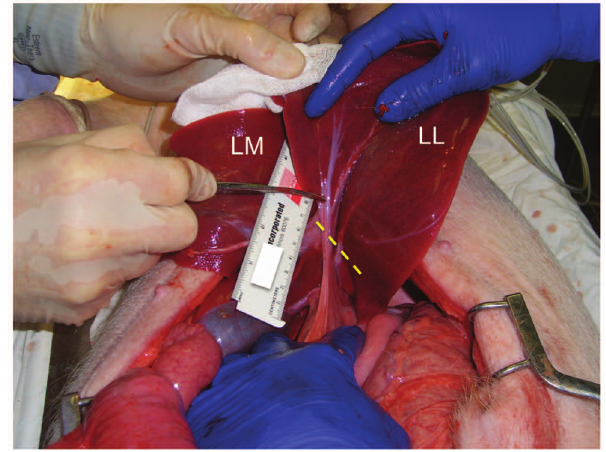
Figure 2. Operative set-up for the porcine noncompressible hemorrhage model. View of the open abdomen in a living anesthetized pig, looking toward the head. The left medial (LM) and left lateral (LL) lobes of the liver have been exteriorized through a ventral midline incision. The dashed yellow line indicates the location of the imminent cut across base of LL lobe. The tips of the scissors are touching the 2 nd LL lobe portal vein branch (refer to Figure 1).